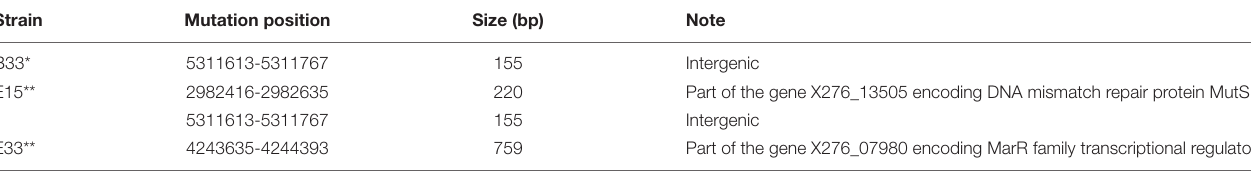
Strain Mutation